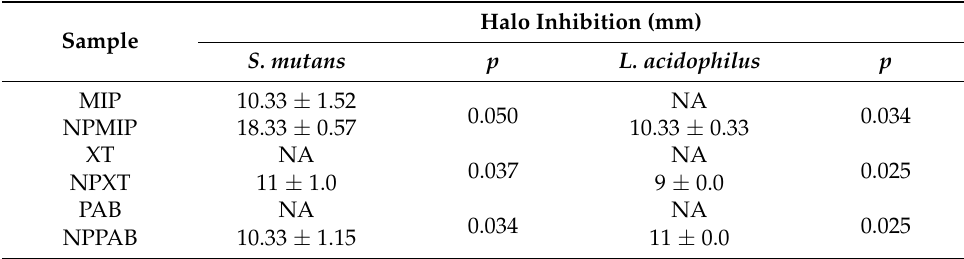
Table 4. Agar template diffusion